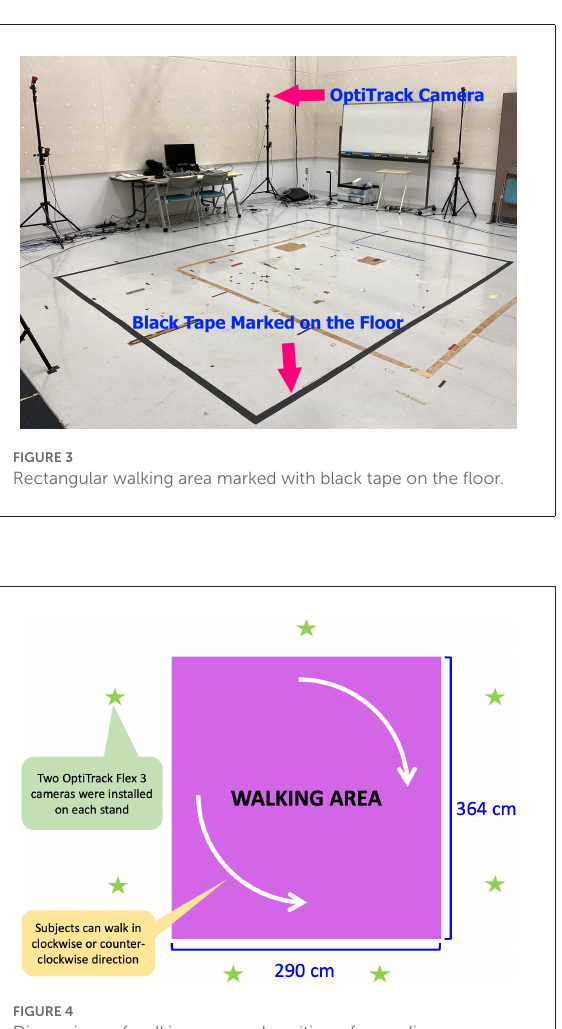
FIGURE4 Dimensions of walking area and position of recording equipment (OptiTrack Flex